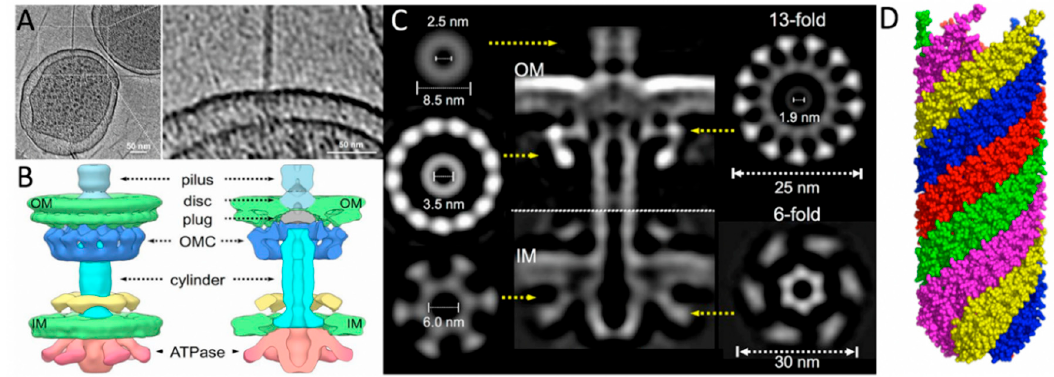
Figure 3. The F-like pilus and T4SS. Figures A – C are in situ structures of the F-like pED208 T4SS by cryo-ET while ( D ) depicts the overall architecture of the pED208 pili by cryo-EM. ( A ) A tomographic slice of an E. coli minicell showing an extended F pilus attached to the OM. ( B ) A three-dimensional depiction of the pED208 core T4SS from ATPase to pilus. At the OM, the pilus narrows and connects to the disc at the junction where the pilus meets the OM complex; a luminal space approximately the same diameter of the pilus is present at this junction, which is sealed by a plug domain. ( C ) A central slice of the averaged structure of the core T4SS with cross-sectional views of the separate domains. The IM complex (the VirB4-like ATPase, TraC) forms a 6-fold rotational domain with a central lumen of ~60 Å with the entire domain spanning 300 Å. The OM complex (the VirB7, -B9, and -B10 homologues TraV, TraK, and TraB) has a 13-fold symmetry and spans 250 Å with a central lumen of 19 Å. ( D ) A side view of the surface representation of the pED208 pilus (PDB ID: 5LEG). It is composed a of a 5-start helical assembly with each helical strand depicted in a separate color. This cryo-EM structure aligns with the architecture of the cryo-ET pilus structure in that it spans ~87 Å and has a central lumen of 28 Å. Figure 3 A – C was adapted from Hu et al. Structural bases for F plasmid conjugation and F pilus biogenesis in Escherichia coli . Proc. Natl. Acad. Sci. USA 2019 , 201904428 [15].